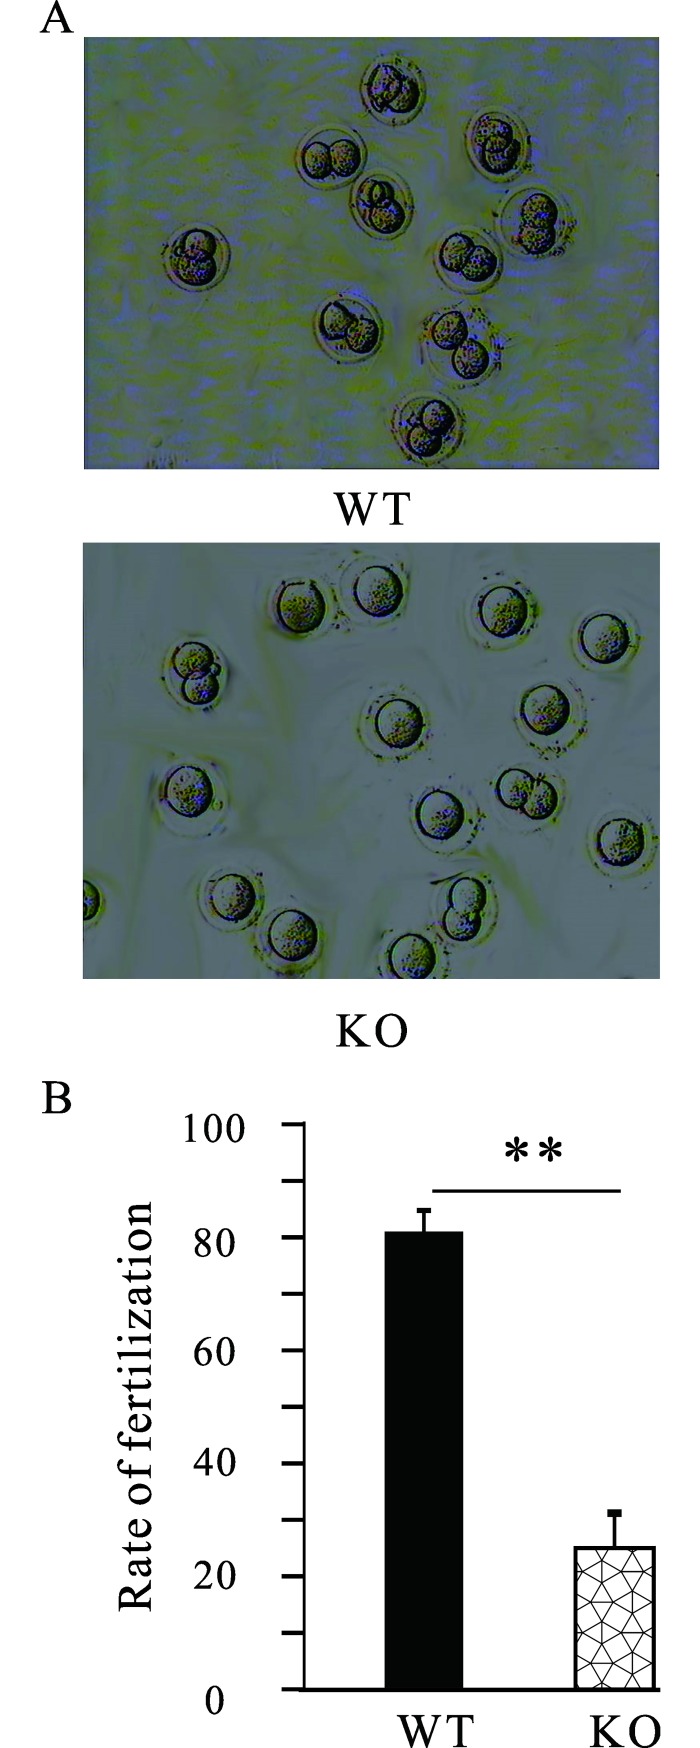
MTMR14 mutation impaired the fertilization ability of sperm in vitro.(A) Representative results of mouse 2-cell embryos derived from in vitro fertilization using sperm from WT and MTMR14-/- mice, respectively (n = 4). (B) Summary of fertilization ratios of oocytes fertilized using WT and MTMR14-/- mice. The proportions of fertilization for WT and MTMR14-/- groups were 81.3% (130/160) and 25.3% (40/158), respectively. **: P < 0.01. These results indicated that MTMR14 deficiency damages fertility in male mice.